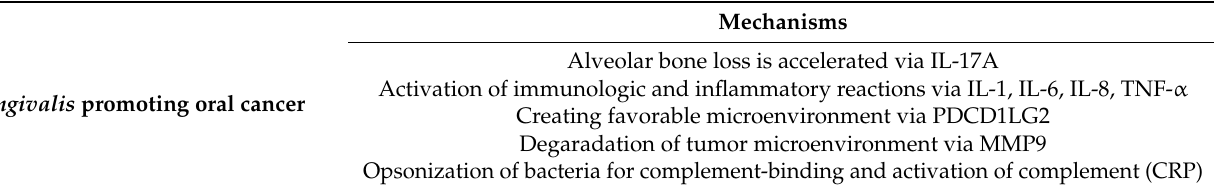
Table 1. Possible mechanism for P.gingivalis promoting oral